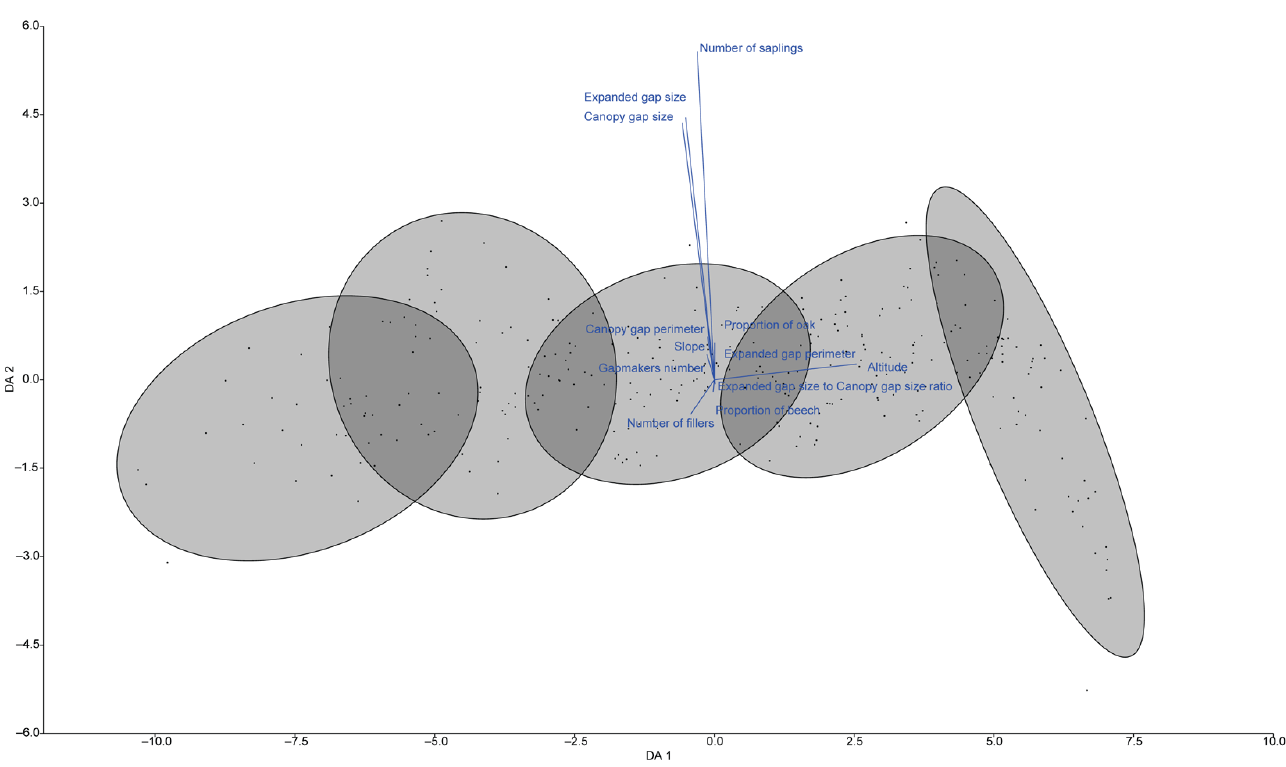
Figure 4. Discriminant analysis (DA) contributions biplot of gaps.